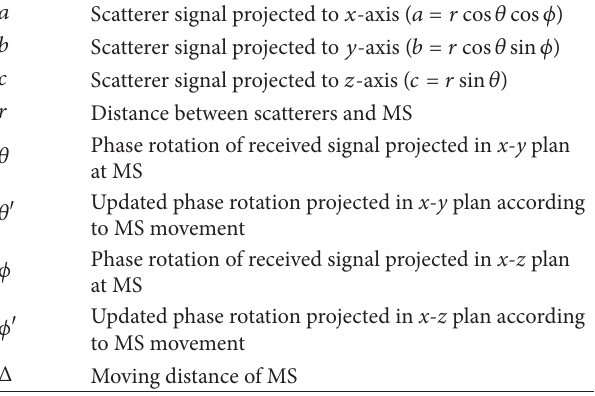
Table 2: 3D scatterer model